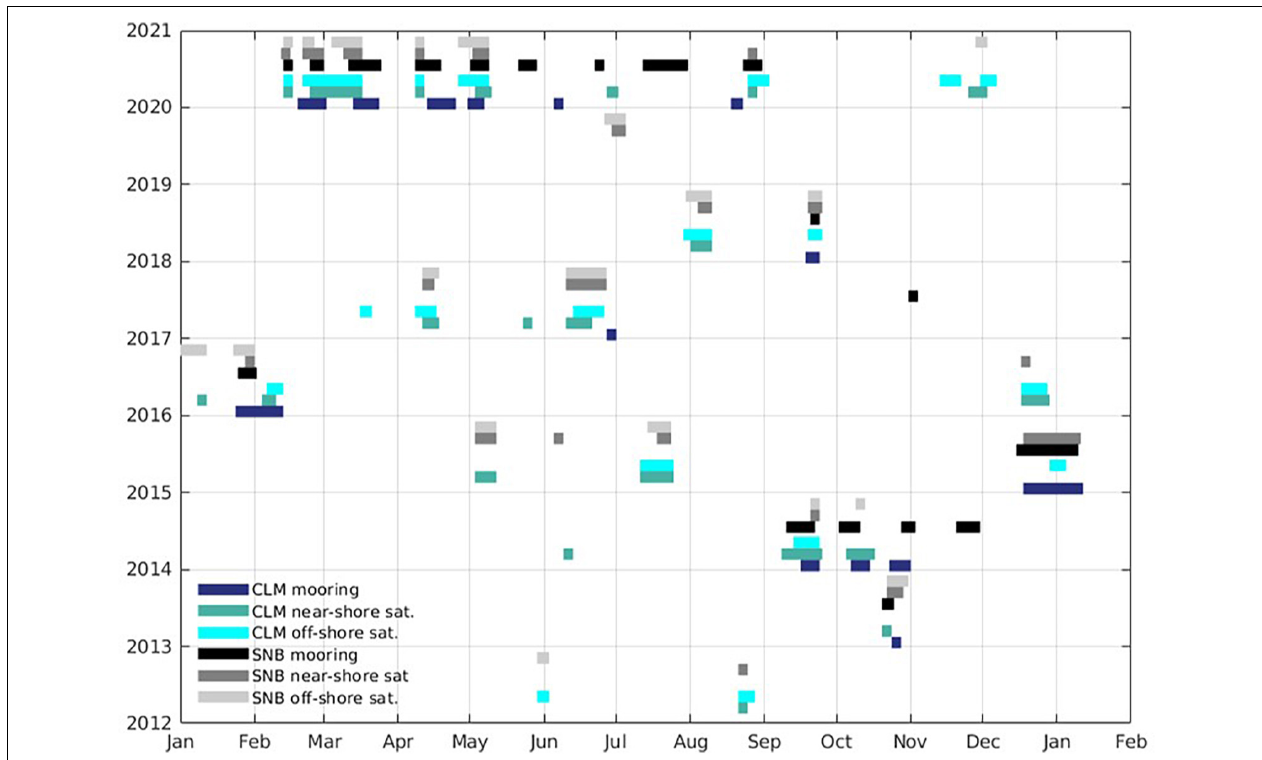
FIGURE 11 | Time-span of MHW events from the mooring, near-shore and off-shore satellite points for single years for Cala Millor (blue colors) and Son Bou (gray colors)